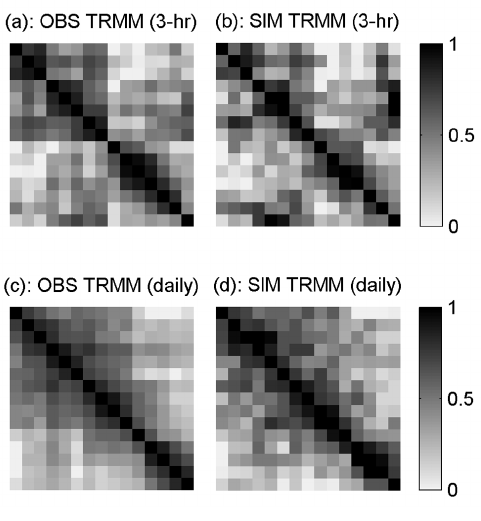
Figure 4. Spearman correlation matrices of observed ((a): 3-hr; (c): daily) and simulated ((b): 3-hr; (d): daily) TRMM precipitation fields.